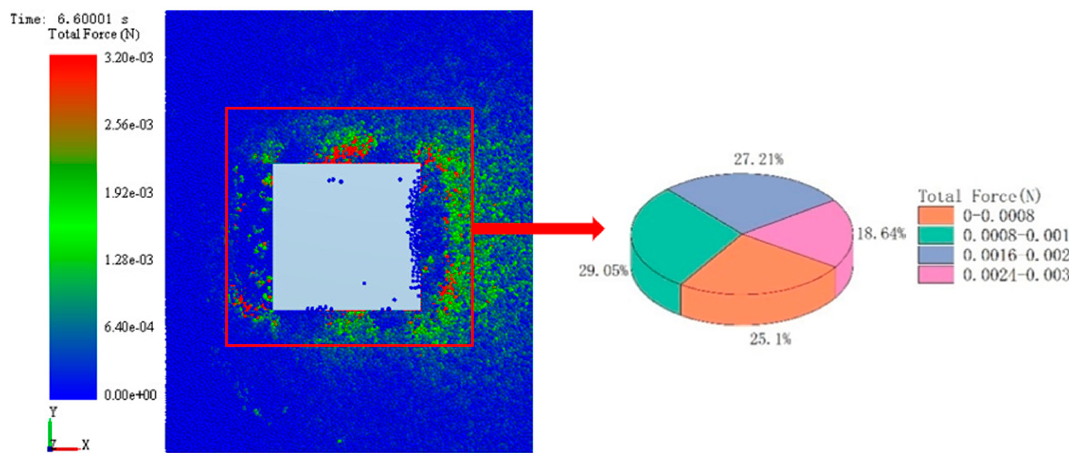
Figure 15. Stress distribution of particles under bionic track shoe.